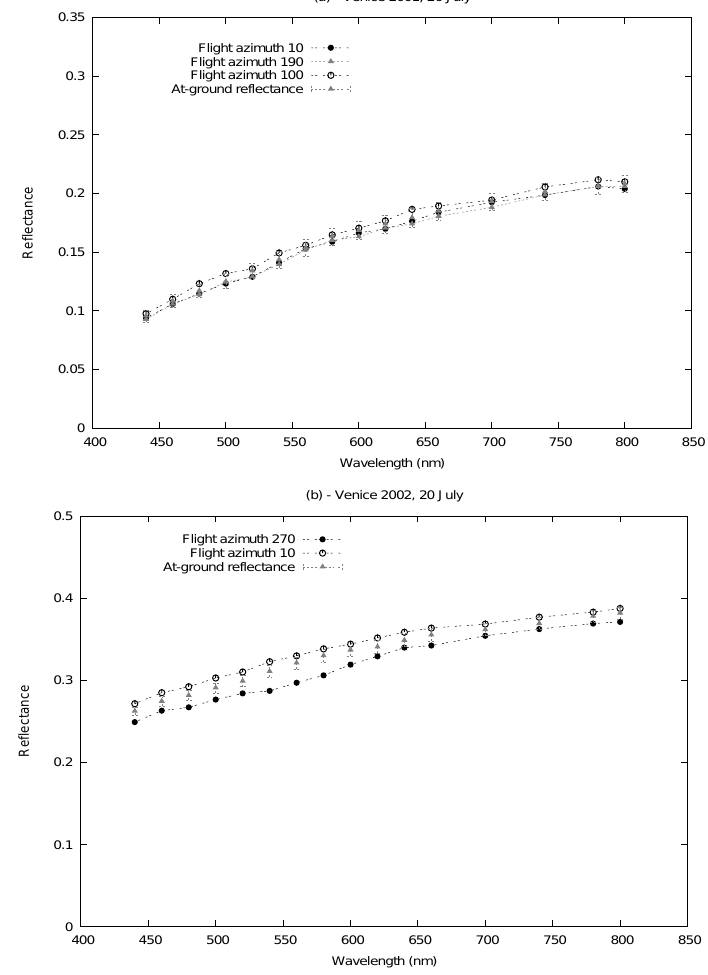
Figure 4 . The surface reflectance, ρ , for all of the MIVIS channels, in the parking area of the Venice airport measured at-ground using the FieldSpec spectrometer (convolved from the MIVIS response function) and retrieved from the atmospheric correction (Module B) of